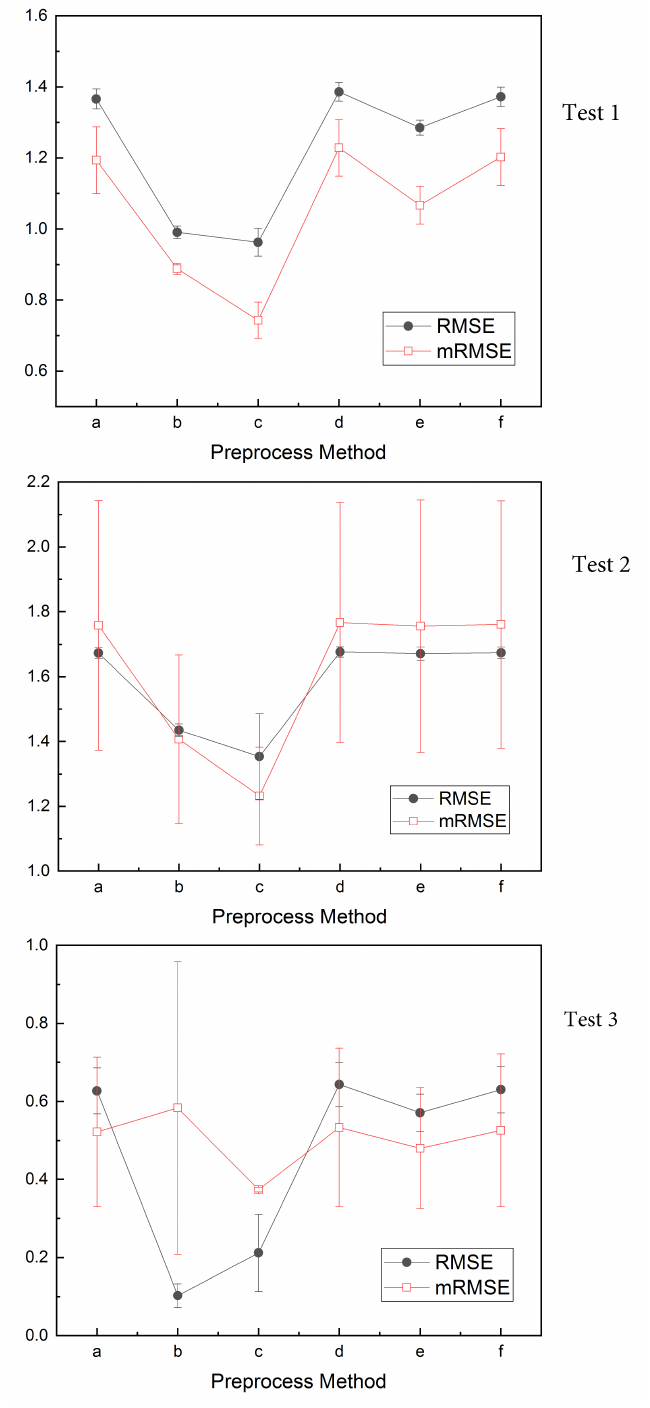
Figure 5. The result of mRMSE and RMSE value comparison for different preprocessed image in test 1, 2, and 3, respectively: ( a ) Raw image; ( b ) Contrast adjustment; ( c ) Histogram equalization; ( d ) Mean filter; ( e ) Log filter; ( f ) Gaussian